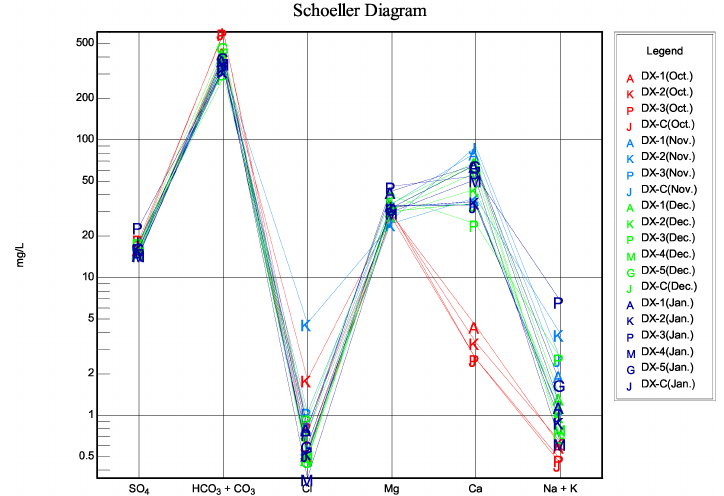
Figure 4. Schoeller diagram of Daxiao Cave. The red, light blue, green, and dark blue labels indicate the sampling points of Daxiao Cave in October, November, and December 2020 and January 2021, respectively.